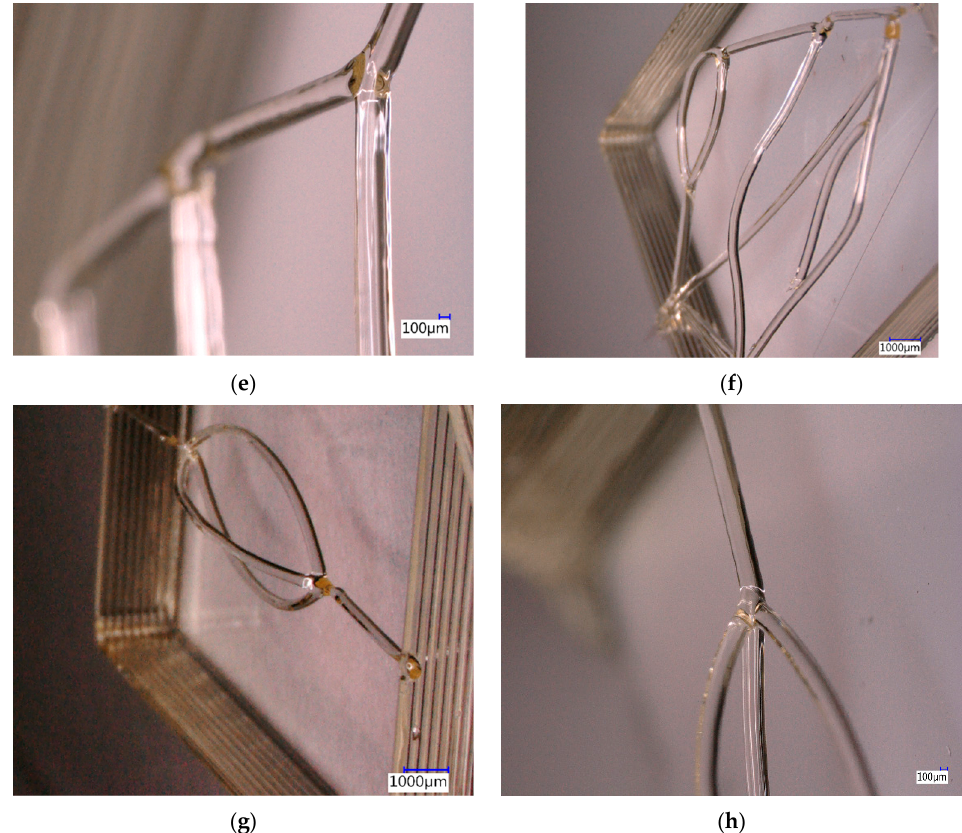
Figure 4. Suspended printed sugar networks and PDMS casts after dissolving the sugar glass: ( a ) Suspended crossing network of sugar glass printed on the framework; ( b ) PDMS cast after dissolving the sugar glass of a similar crossing network; ( c ) Second order bifurcating sugar glass network; ( d ) PDMS cast after dissolving the sugar glass of a similar second order bifurcating network. Dashed areas are for the PIV measurements in Figure 5; ( e ) Detailed image of the bifurcation, showing the monolithic in-plane structure of the circular cross-sectional fibres; ( f ) 3D sugar glass network structure with the straight fibre curving downwards and the diagonal fibre curving upwards; ( g ) Curved trifurcation sugar glass network with the middle fibre curving upwards, while other fibres are in-plane; ( h ) Detailed image of the trifurcation, showing the fusion of the three fibres into a single monolithic trifurcation. Scale bars for the perspective images are only valid for the focussed part.